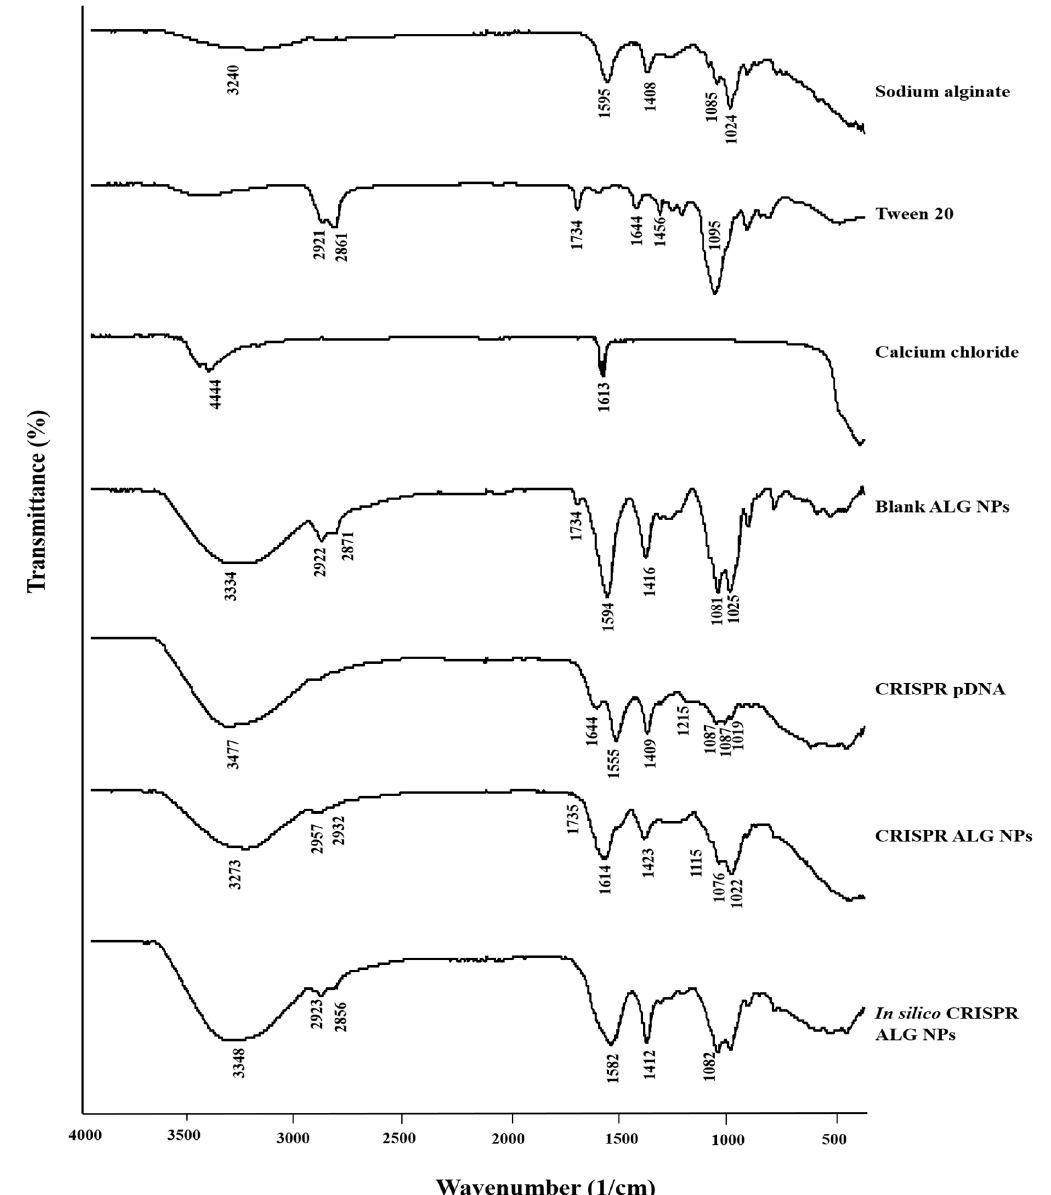
Figure 5. Attenuated Total Reflectance-Fourier Transform Infrared Spectroscopy spectra of sodium alginate, Tween 20, calcium chloride, CRISPR pDNA, blank ALG NPs, and CRISPR ALG NPs.